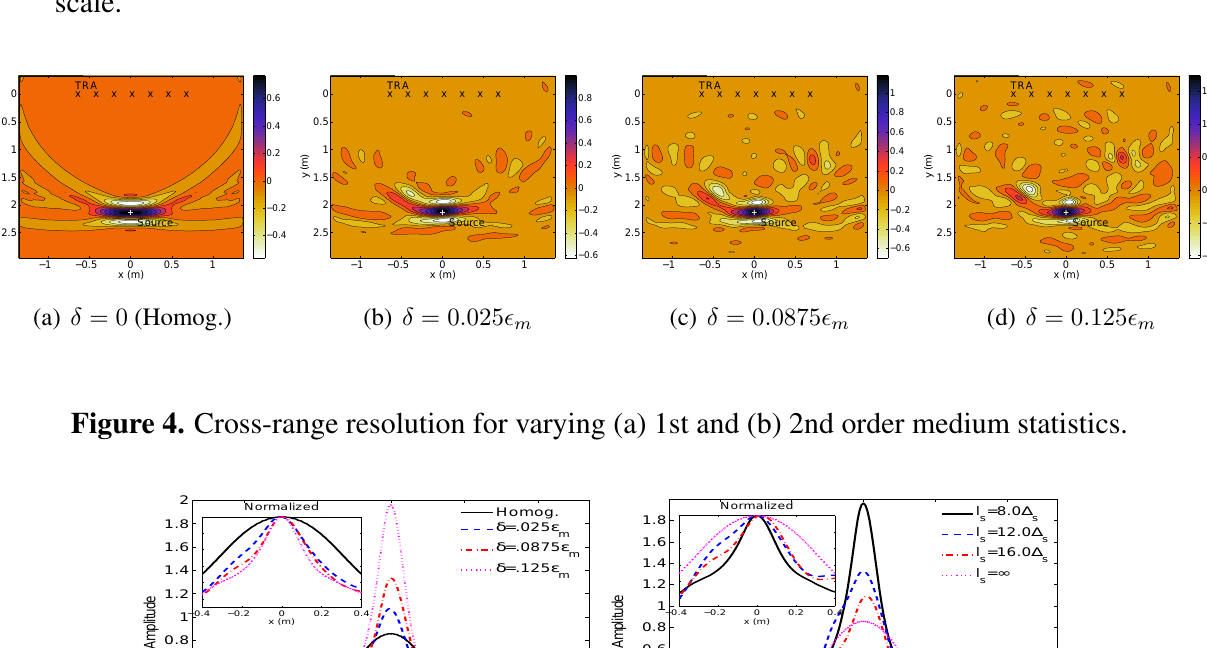
field component of the electric field z of l = 8∆ . Plots are given in linear s s s